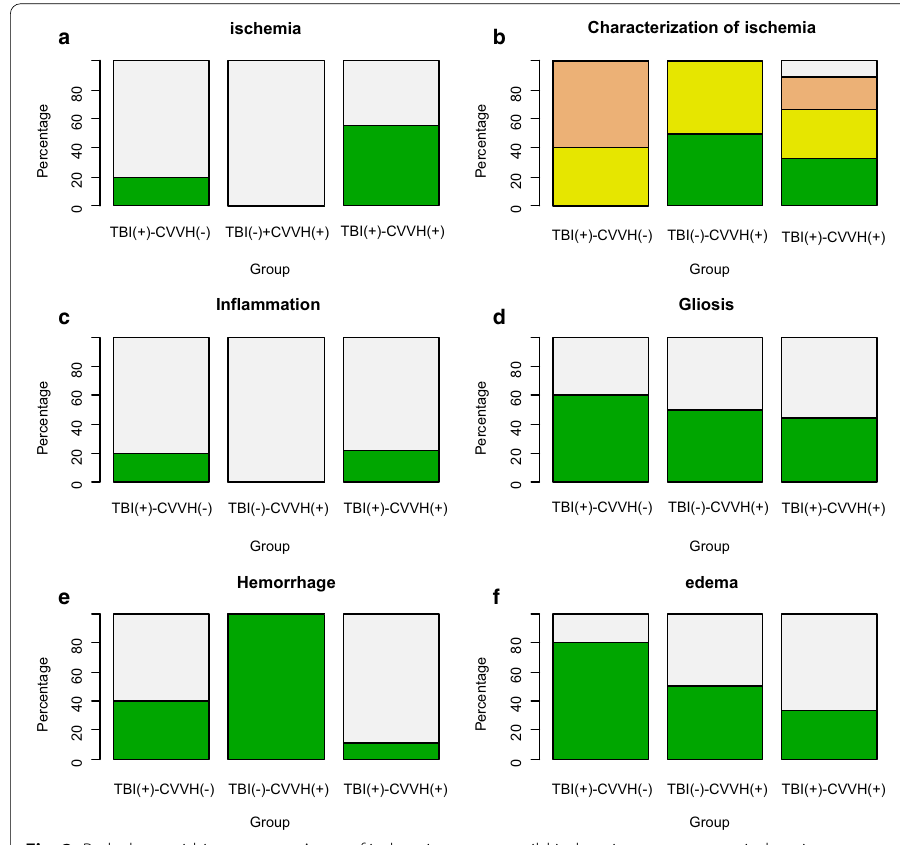
Fig. 2 Pathology within groups. a Areas of ischemia, green mild ischemia, grey severe ischemia. = = b Location of ischemia, green isolated and diffuse, grey multiple and focal, brown multiple and = = = diffuse, yellow isolated and focal. c Green normal areas without inflammation, grey presence of = = = inflammation. d Green normal areas without gliosis, grey presence of gliosis. e Green areas without = = = hemorrhage, grey presence of hemorrhage. f Green areas without edema, grey presence of edema. = = = TBI( )‑CVVH( ) traumatic brain injury group ( n 5). TBI( )‑CVVH( ) hemofiltration group ( n 2). + − = = − + = = TBI( )‑CVVH( ) combined traumatic brain injury group adding all rabbits with hemofiltration before and + + = after the trauma ( n =